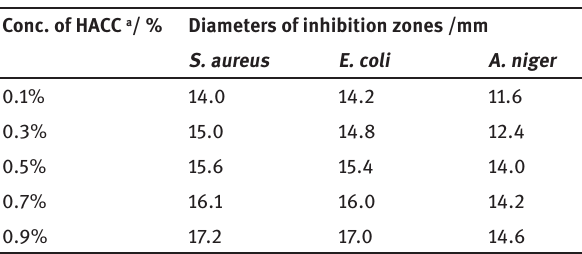
Table 2: The antimicrobial activity of handsheets. Conc. of HACC a /